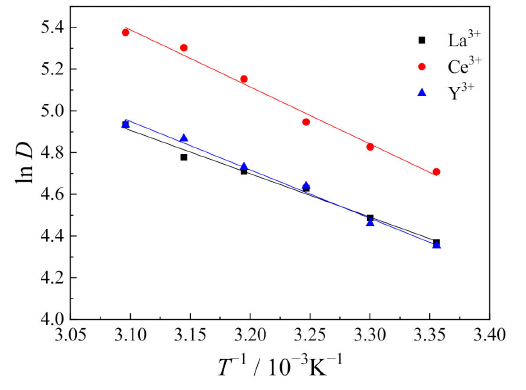
Figure 11. Linear fit plot of ln D vs. T −